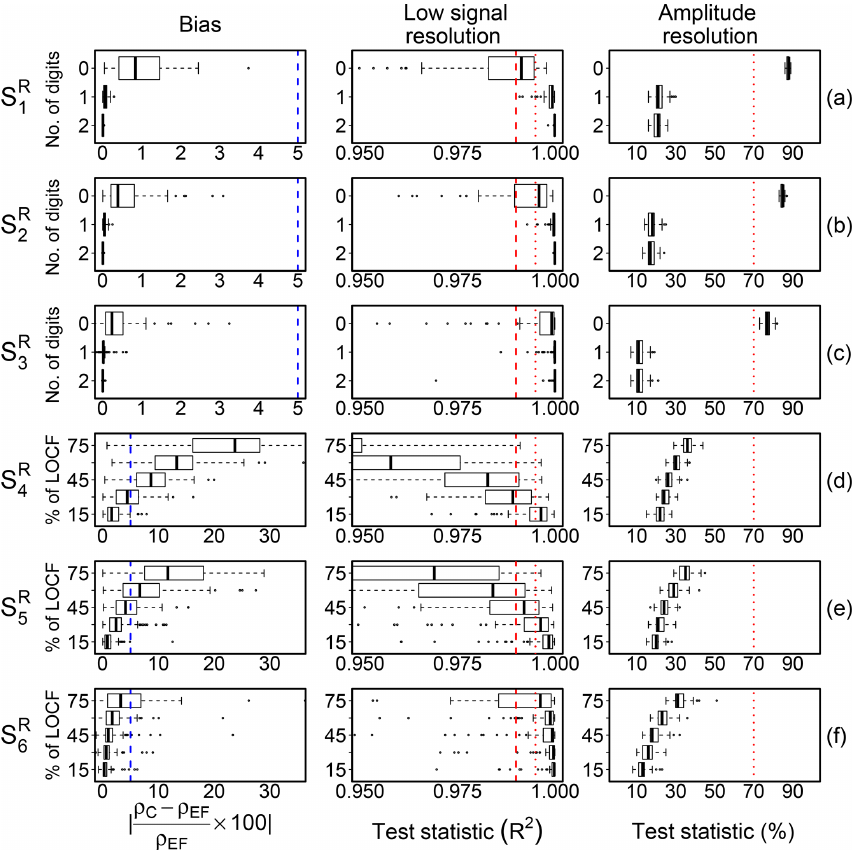
Figure 3. Bias effect of low-signal-resolution problems and test performance evaluation in the S R scribed in Sect. 3.1.1. The left panels show the difference in percentage between correlation estimated on error-free time series ( ρ EF ) and on data contaminated ( ρ C ) by low-resolution problems (dashed blue line indicates 5% bias). The middle panels show the distribution of the test statistic ( R 2 ) for the low-signal-resolution (LSR) test; dashed red lines indicate the threshold values at 0.99 and 0.995 adopted for defining the SevEr and ModEr statements, respectively. The right panels show the distribution of the amplitude resolution test statistic by VM97; dashed red lines indicate the threshold value at 70% as recommended by the authors for assigning a hard flag to data. In the S R (d) scenarios, the AR processes were simulated with φ = 0 . 90, in S R and S R 4 φ = 0 .